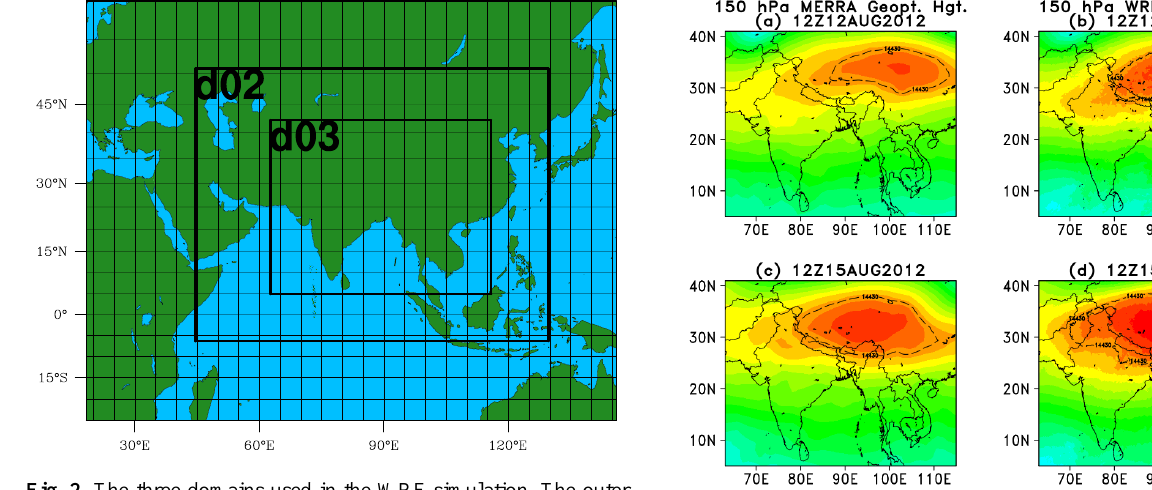
Fig. 2. The three domains used in the WRF simulation. The outer domain has 36km grid spacing, domain 2 (d02) 12km, and domain 3 (d03) 4km. All analyses presented in this paper are based on re- sults from domain 3.